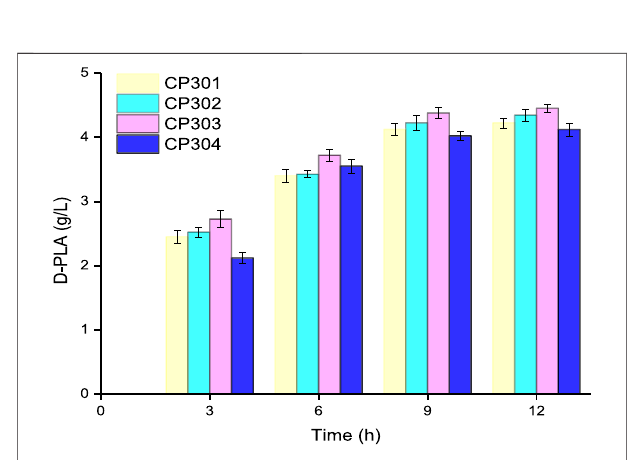
FIGURE 4 | Time course of the production of D-PLA by fusion protein strains CP301, CP302, CP303, and CP304. Data are means ± SD ( n (cid:1) 3).